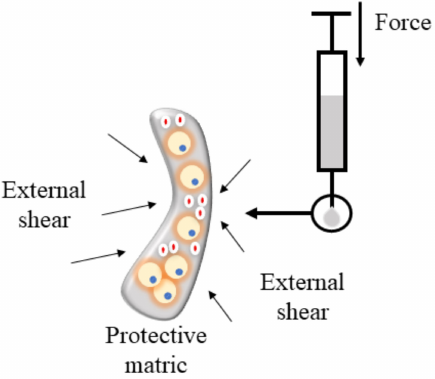
Figure 4. Hydrogel protects cells during